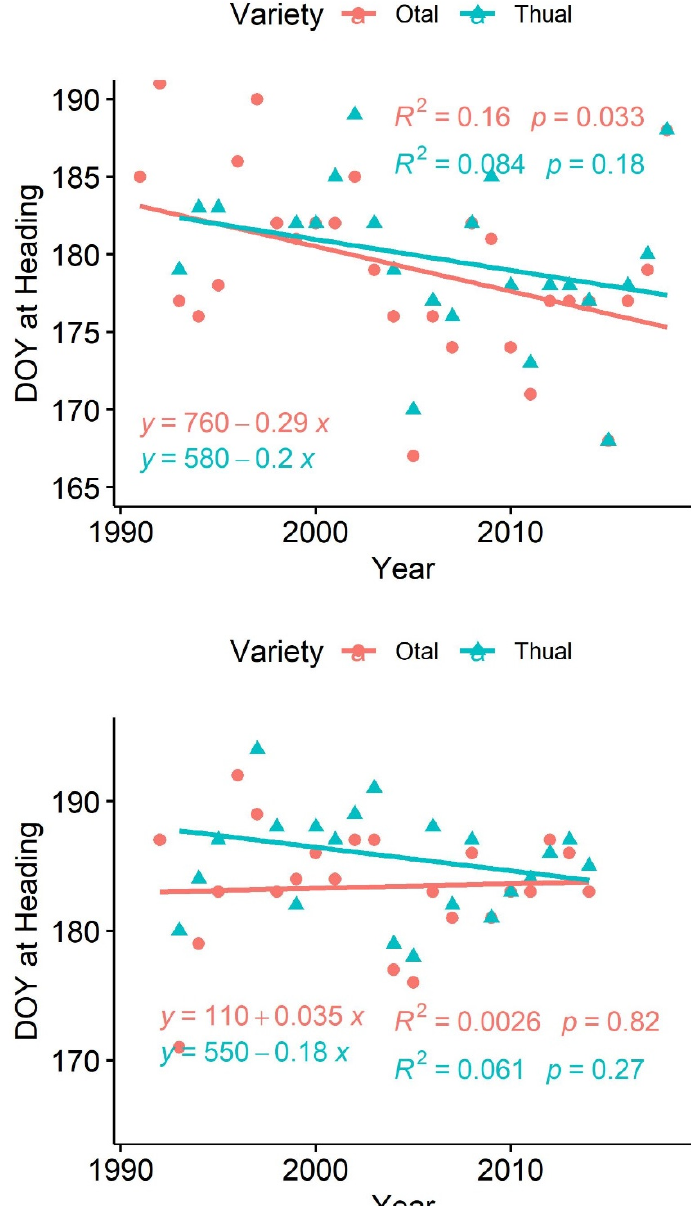
Figure 2. Linear trends of the heading dates of ‘Otal’ and ‘Thual’ from 1991 to 2018 in Fairbanks (Top) and from 1992 to 2014 in Delta Junction, Alaska (Bottom). DOY=Day of Year.